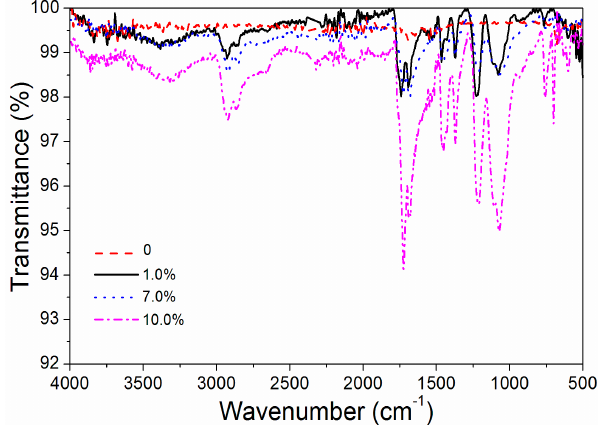
Figure 9. Influence of black paste content on the infrared spectra of the coatings.